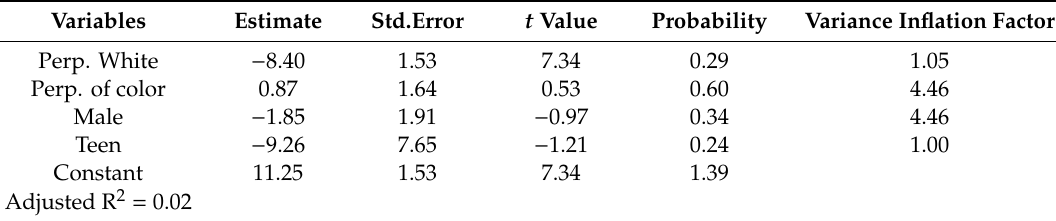
Table 1. Regression of traits of perpetrator (Female serves as the referent category for gender. Age of perpetrator was collapsed into ordinal categories; there were insu ffi cient incidents for child and adult suspects to calculate regression data) and animal cruelty.